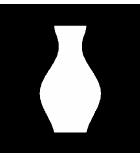
Fig. 8 Mask for the “Vase” dataset. The gradient values are only known on a non-rectangular part Ω of the grid, represented by the white region. The FM and the CG-Poisson integrators can handle easily any form of domain Ω. In contrast FFT, DCT, and Sylvester rely on a rectangular domain and therefore the values [ p,q ] := [0 , 0] need to be fixed outside Ω, in the black